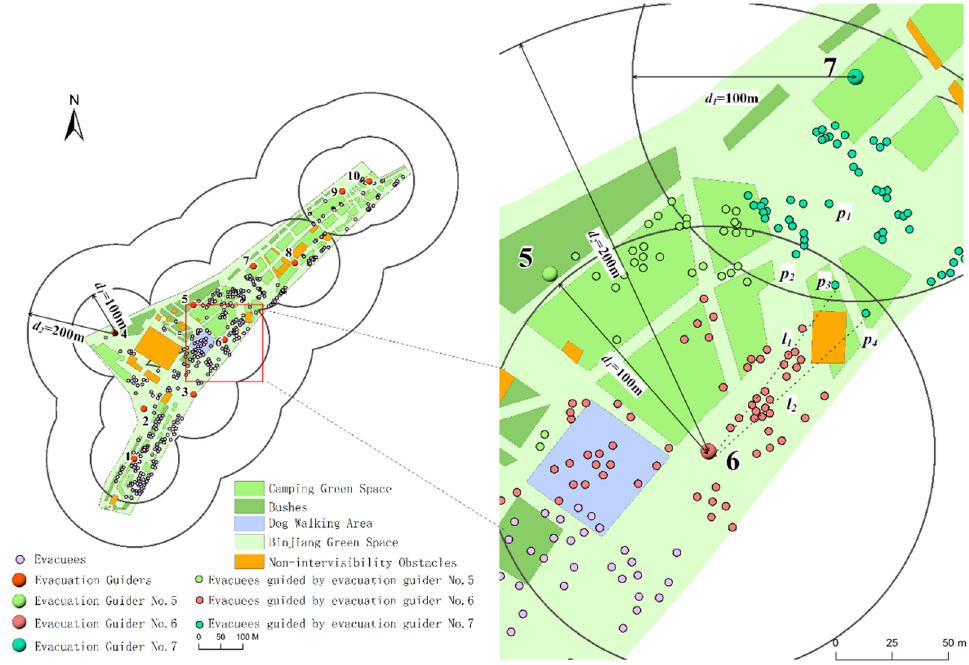
Figure 17. Schematic diagram of the allocation of the evacuation guiders, and the guiding relation between the guiders and the evacuees (based on the proposed method in this paper) at 9:30 on 5 May 2021.